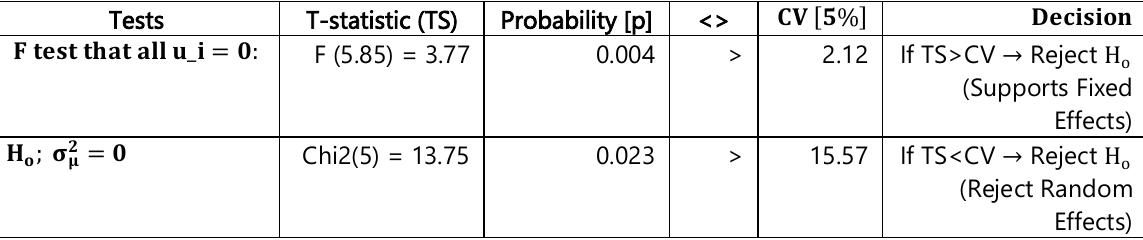
Table 4: Comparison of FE and RE (Source: Authors’ calculation) Tests T-statistic (TS) Probability [p] <> 𝐂𝐕 𝟓% 𝐃𝐞𝐜𝐢𝐬𝐢𝐨𝐧 𝐅 𝐭𝐞𝐬𝐭 𝐭𝐡𝐚𝐭 𝐚𝐥𝐥 𝐮_𝐢 = 𝟎: F (5.85) = 3.77 0.004 > 2.12 If TS>CV → Reject H 𝐇 ; 𝛔 𝛍𝟐 = 𝟎 𝐨